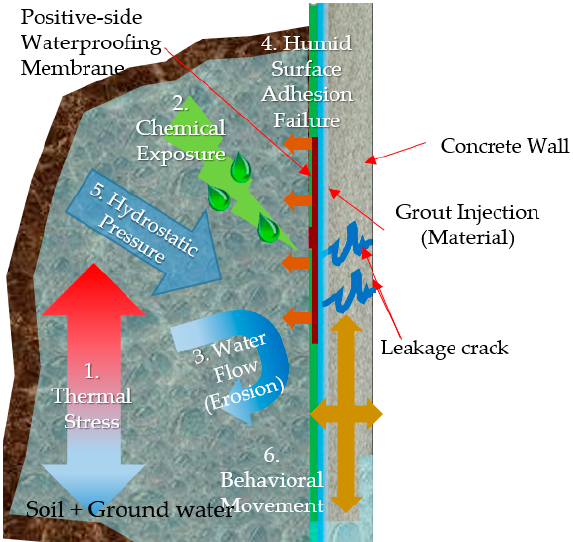
Figure 1. The six types of degradations applied to waterproofing membranes in below-grade structures.